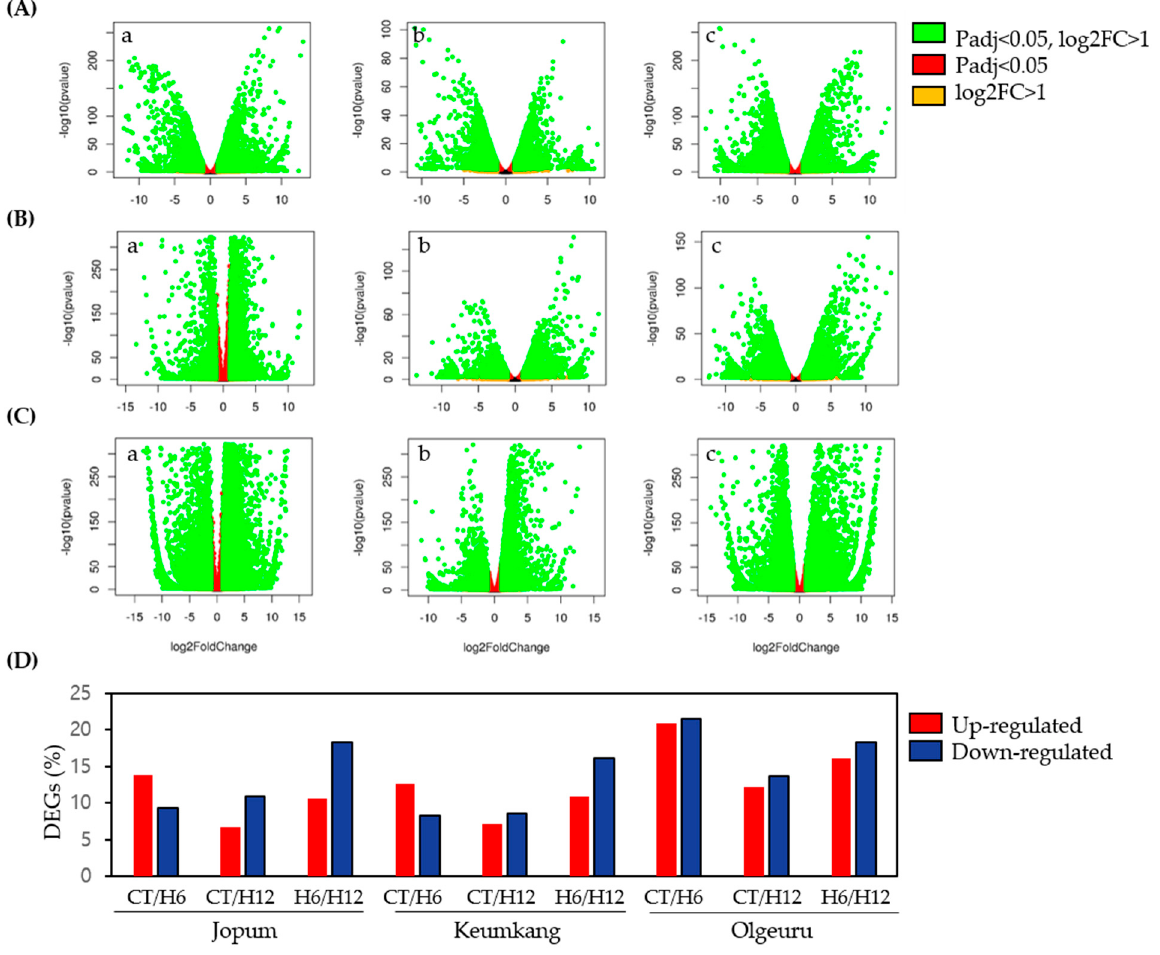
Figure 2. Volcano plot of differentially-expressed genes under heat stress in three cultivars. ( A – C ) DEGs in heat-treated groups in Jopum ( A ), Keumkang ( B ), and Olgeuru ( C ). ( D ) The numbers of DEGs found in CT vs. H6 ( a ), CT vs. H12 ( b ), and H6 vs. H12 ( c ) of heat treatment. Screening criterion for DEGs was Padj < 0.05. Log2 ratio stands for log fold changes (FC) using the ratio base 2 logarithm. Padj, adjusted p -values; CT, untreated control seedling; H6, 6 h heat treatment; H12, 12 h heat treatment.